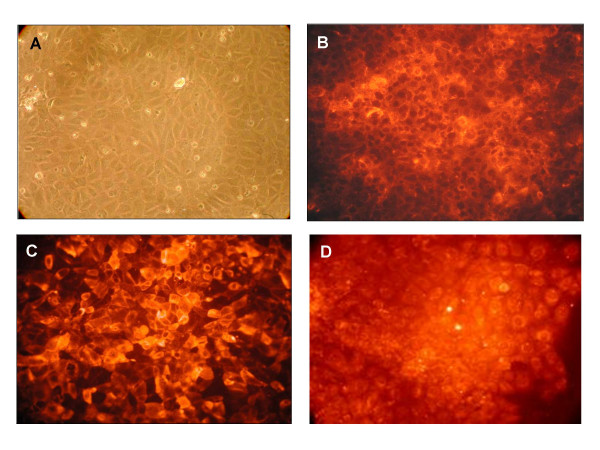
Establishment of hepatic endothelial cells (HEC). A. Phase contrast image of HEC. B. Immunofluorescent staining for VCAM-1 in HEC. C. Immunofluoresent images of mouse endothelial cell antigen-32 (MECA-32) expressed on the surface of HEC monolayers. D. Distribution of DiI-labeled acetylated low density lipoprotein -(LDL), an endothelial cell specific biomarker incorporated into endothelial cells by receptor mediated endocytosis.